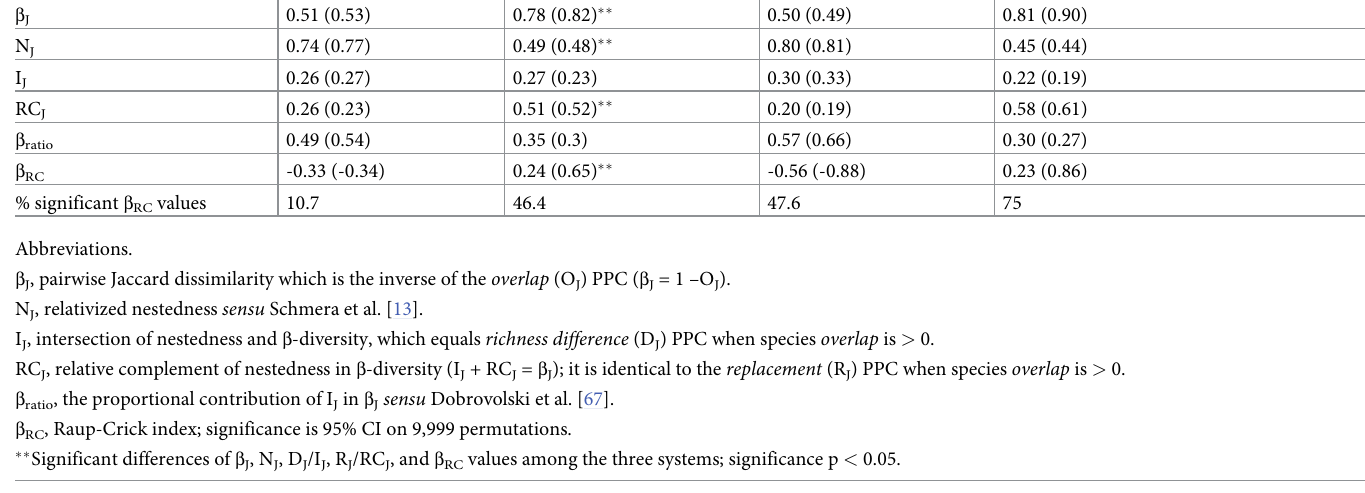
relative complement (Table 4), although it strongly influences some β -diversity values given (Table 4), and about 46% (13/28) of pairwise values fall beyond the 95% CIs. While three sites (Daikoku, Kasuga-2 and Nikko) and a pair (NW Eifuku and NW Rota2) are significantly more